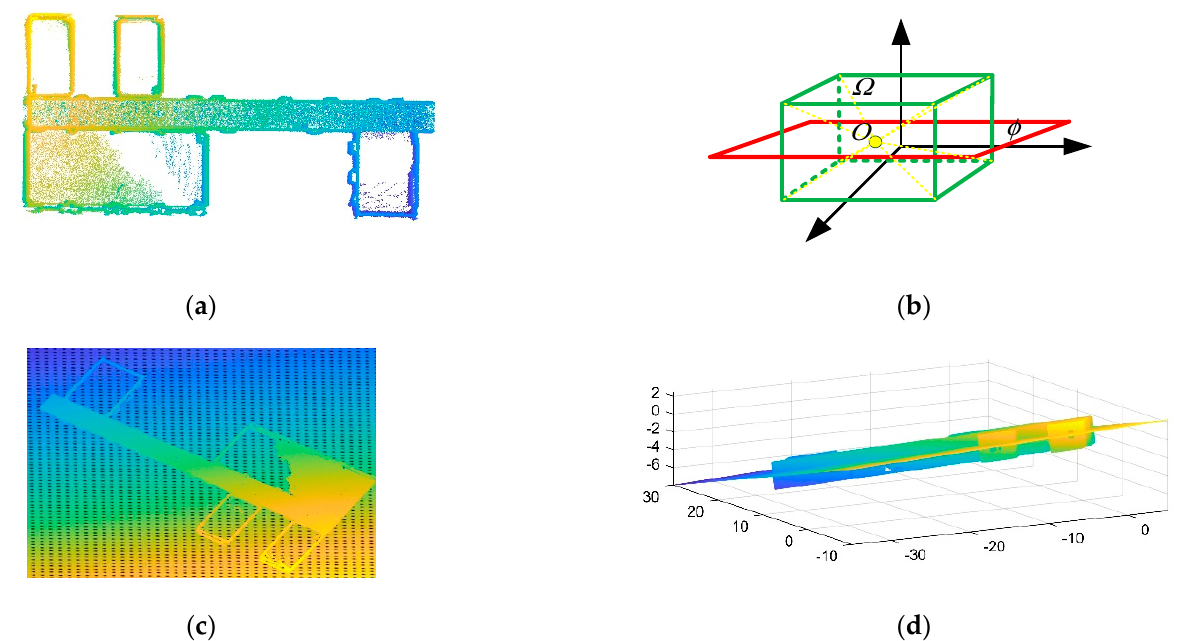
Ω Figure 3. PCA is used to find cross-sections of the data: ( a ) raw point cloud data; ( b ) suppose that Ω is a cuboid composed Figure 3. PCA is used to find cross-sections of the data: ( a ) raw point cloud data; ( b ) suppose that is a cuboid φ of point clouds and O is the average value of data; φ is the plane determined by the normal vector and O obtained from is the plane determined by the normal vector and Ο composed of point clouds and Ο is the average value of data; PCA; ( c , d ) the plane fitted in the raw data by PCA. obtained from PCA; ( c , d ) the plane fitted in the raw data by PCA.